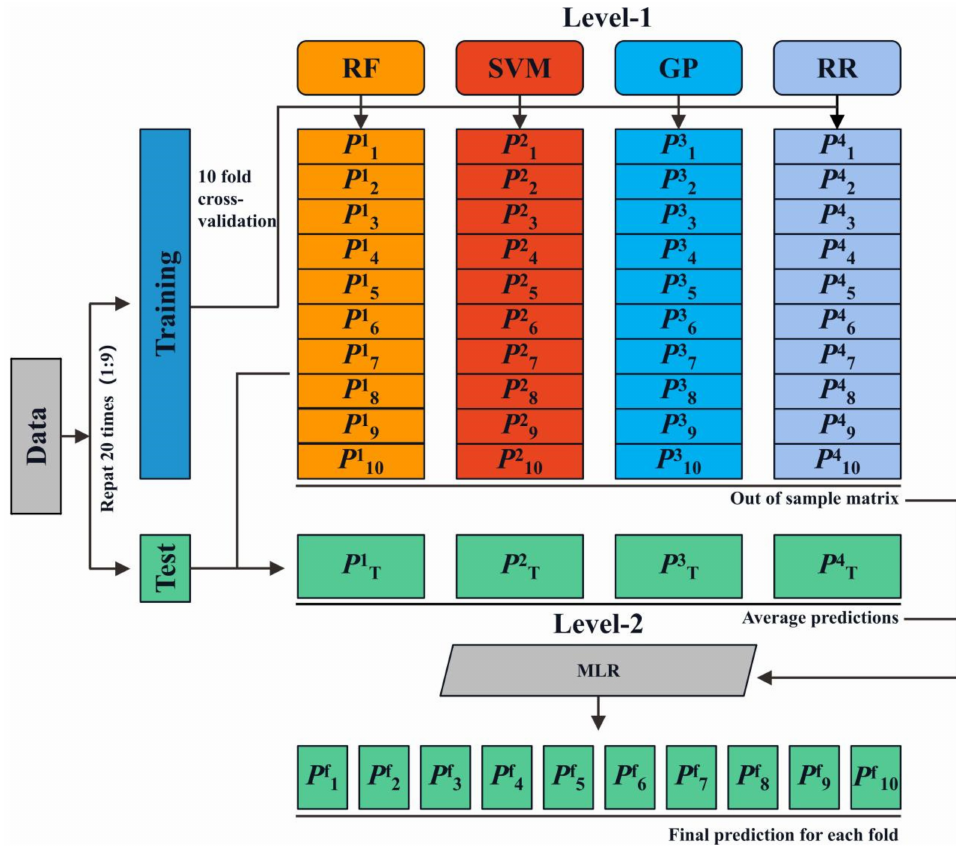
Figure 2. The workflow of the stacking regression model for grain yield prediction; RF, random forest; SVM, support vector machine; GP, Gaussian process; and RR, ridge regression. P are model